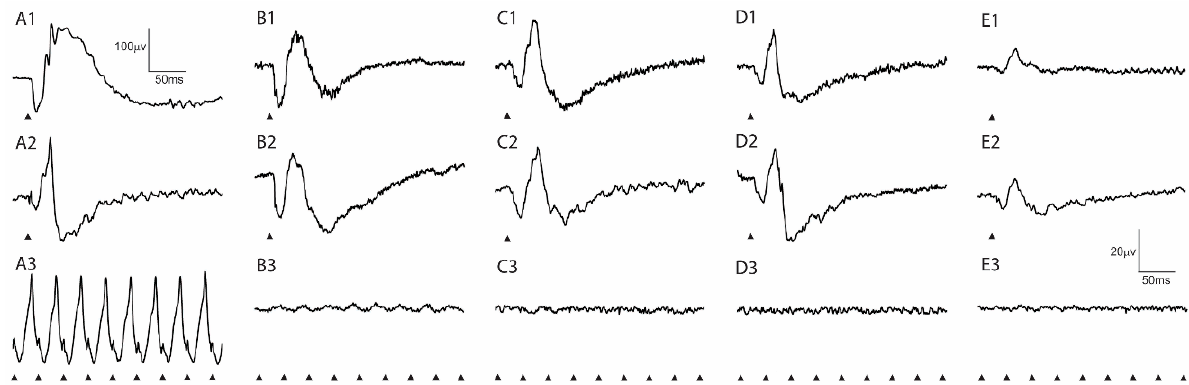
Figure 3. Representative ERG responses showing a decline in amplitudes with age. Shown are representative dark-adapted (1) and light-adapted (2) ERG responses to strong stimuli (2.82 and 2.38 log cdS/m 2 , respectively) and 33 Hz flicker responses (3) (0.39 log cdS/m 2 imposed on a background light of 30 cd/m 2 ). ( A ). Wild-type dog (17 months of age). ( B – E ). Rpe65-deficient dogs at 3, 5, 30 and 62 months of age. The triangles indicate the timing of the flash stimulus. Scale: the 20 µ v × 50 ms scale bars are for all images except the wild-type dark-adapted recording ( A1 ) which uses the 100 µ v × 50 ms scale